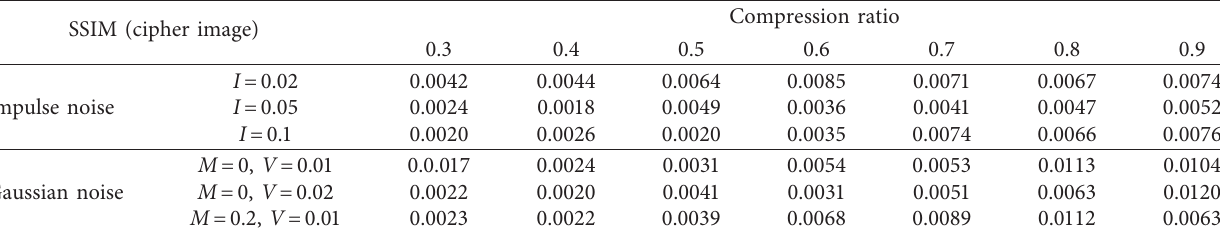
Table 6: Structural similarity between original image and cipher